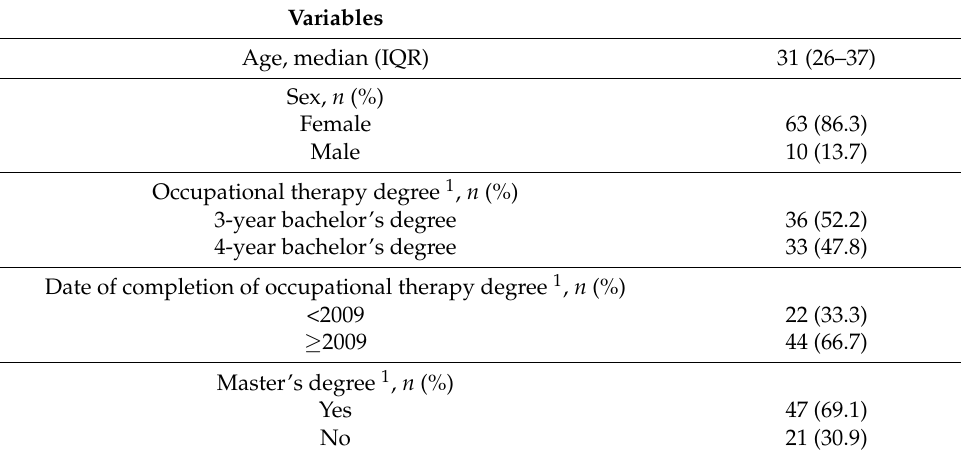
Table 1. General characteristics of the study participants ( n =